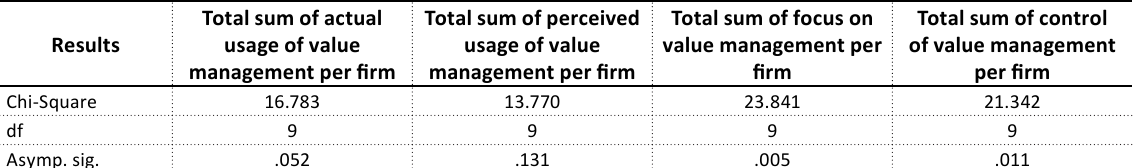
Source: SPSS (v. 20).